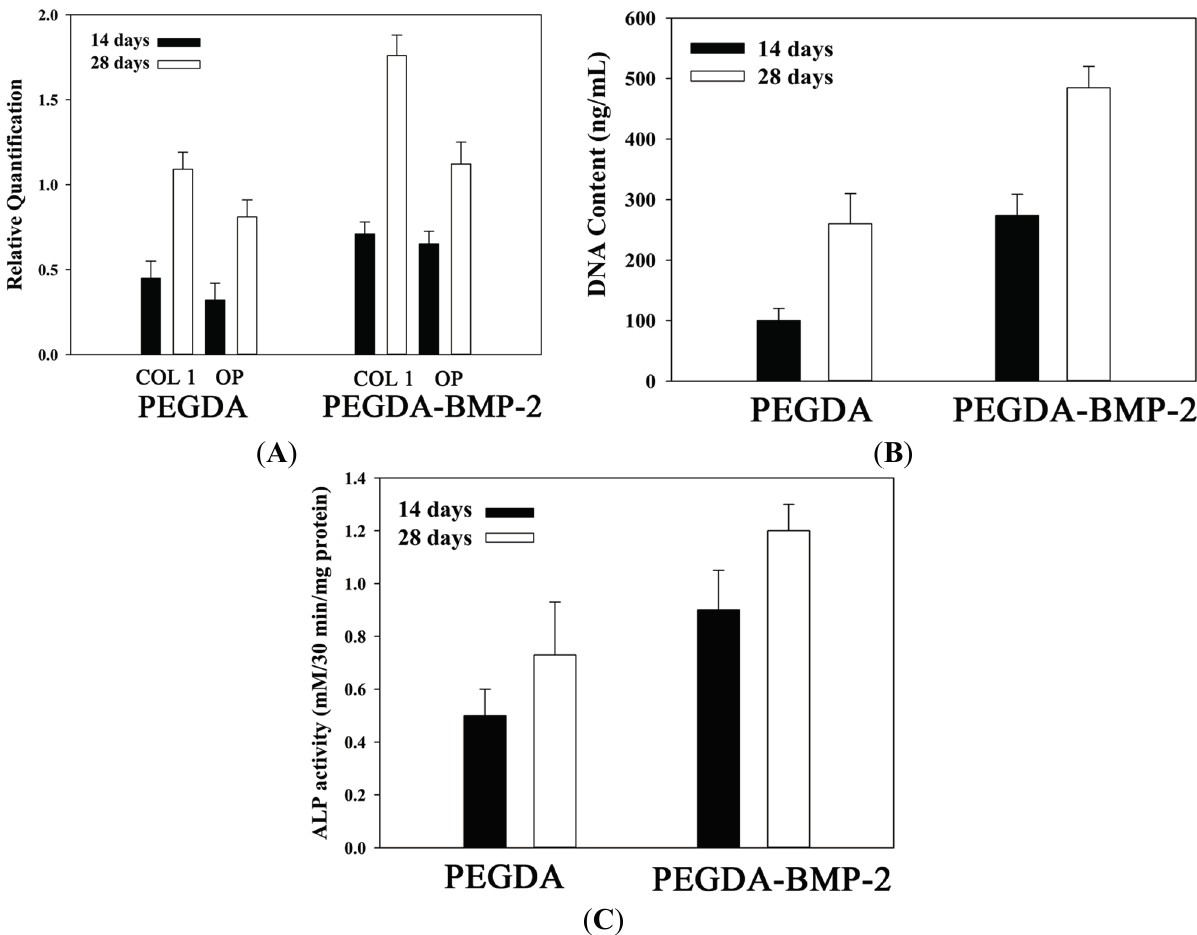
Figure 4. Quantitative analyses of osteogenic gene expressions ( A ); cell proliferation ( B ), and alkaline phosphates secretion ( C ) of LFs cultivated in PEGDA and PEGDA-BMP-2 photo-responsive hydrogels. Triplicates were used for each experiment. For gene expressions of COL I and OP after 28 days cultivation, PEGDA-BMP-2 group showed higher than PEGDA group ( p < 0.05). For cell proliferation after 28 days cultivation, PEGDA-BMP-2 group showed higher than PEGDA group ( p < 0.05). For ALP secretion, PEGDA-BMP-2 group showed higher than PEGDA group ( p <